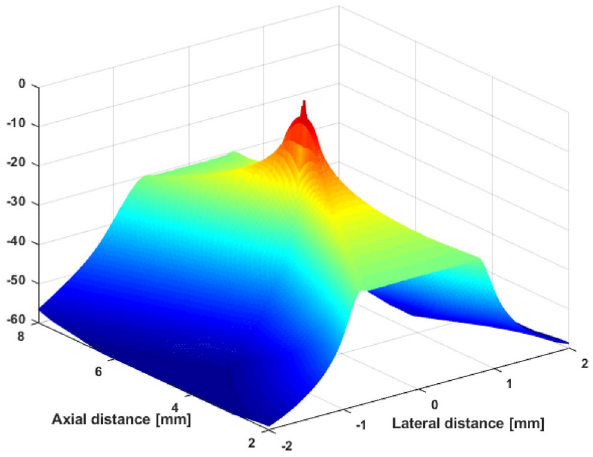
Fig. 5 The 3D profile of the simulated pressure field resulting from the probe. This profile was simulated using Field II